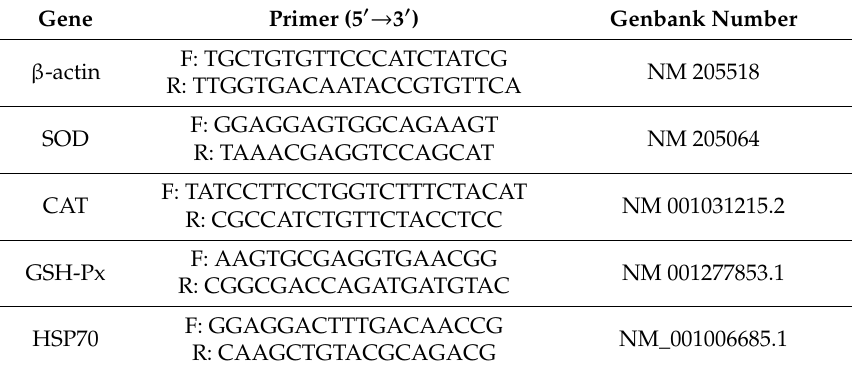
Table 2. Specific sequences primers used in the qRT-PCR 1 .